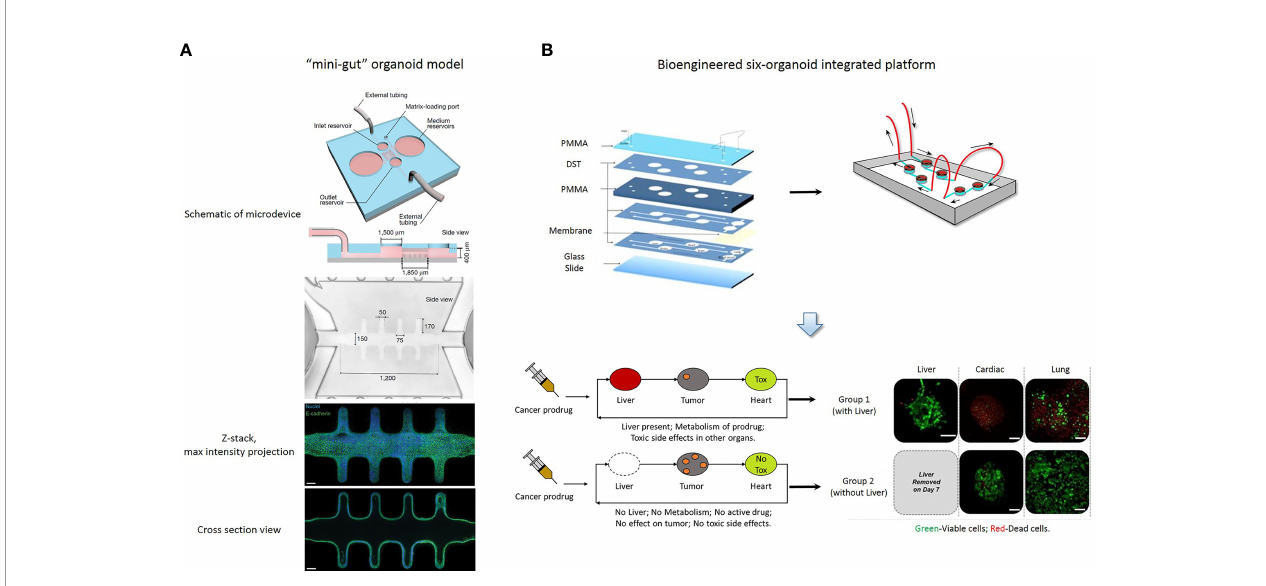
FIGURE 2 | (A) A “ mini-gut ” organoid model is established in a microdevice containing 3D hydrogel. This microdevice guides self-organizing intestinal stem cells into functional organoids-on-a-chip. [Cited from (75)]. (B) A bioengineered six-organoid integrated platform is generated by micro fl uidically linked chambers, each containing liver, cardiac, lung, endothelial, testis, and brain organoids. Capecitabine treatment of a system containing liver, results in cytotoxicity in cardiac and lung organoids. Expectedly, this platform without liver organoids does not show signi fi cant toxicity. Green, Calcein AM-stained viable cells; Red, Ethidium homodimer- stained dead cells. PMMA, poly (methyl methacrylate); DST, double sided tape. Scale bars, 100 m m. [Adapted from